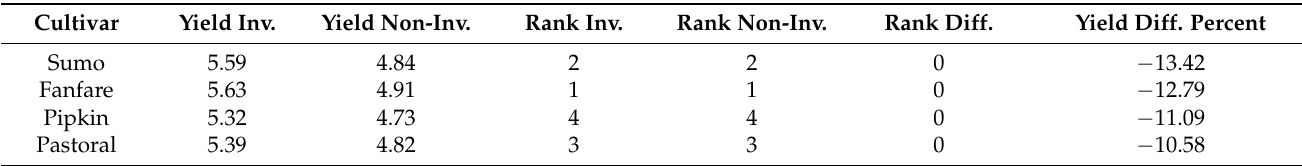
Table 3. Ranking of four winter barley cultivars grown from 2004 to 2014 by the difference between their inversion and non-inversion yield ranking.